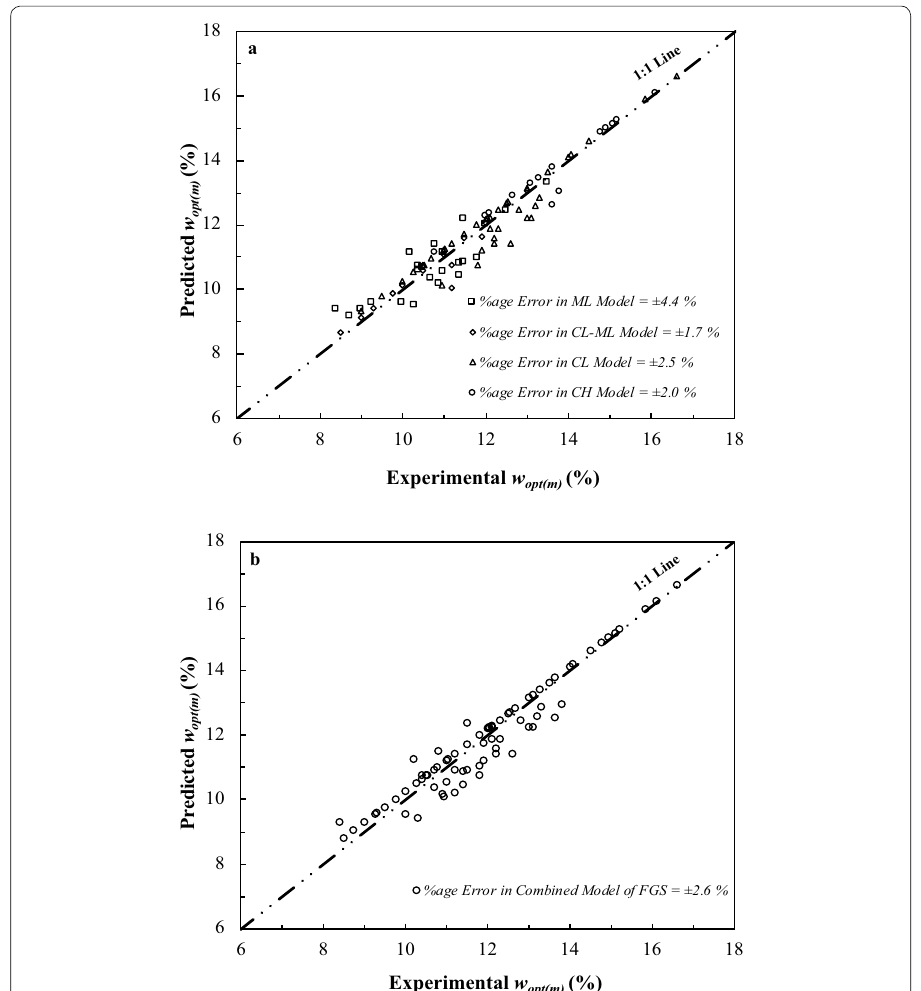
Fig. 11 Experimental versus predicted values of w opt(m) based on data used to develop models ( a ) by using models developed for the FGS ( b ) by using combined model of